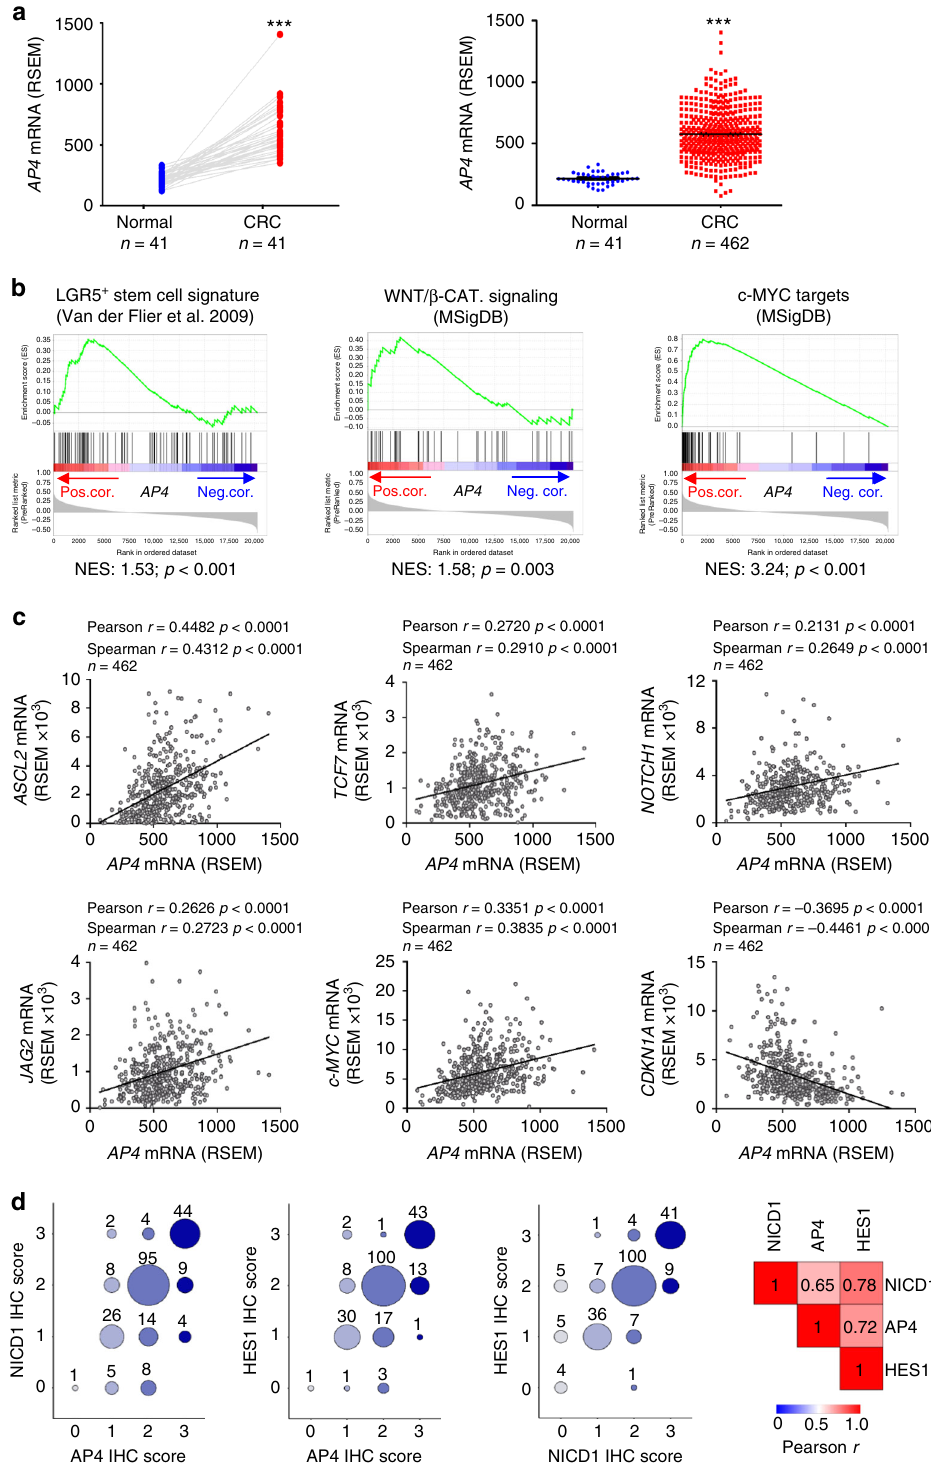
In situ hybridization . For detection of ISCs with an Olfm4 mRNA probe, the Bluescript II plasmid p695-pBS-mOlfm4 (kindly provided by Prof. Hans Clevers) was linearized by using a Not I restriction enzyme. The pCMV6 entry plasmids containing the Lgr5 or Smoc2 open reading frame (ORF) were obtained from Origene with the catalog number MR219702 or MR207121, respectively. Both ORFs were cloned into the pBSII KS plasmid by using the restriction enzymes Not I and Kpn I. The pBSII KS-mSmoc2 was linearized with the Kpn I restriction enzyme and the pBSII KS-mLgr5 was linearized with the Bcl I restriction enzyme. The Olfm4 , Lgr5 and Smoc2 RNA probe has was generated by an in vitro transcription